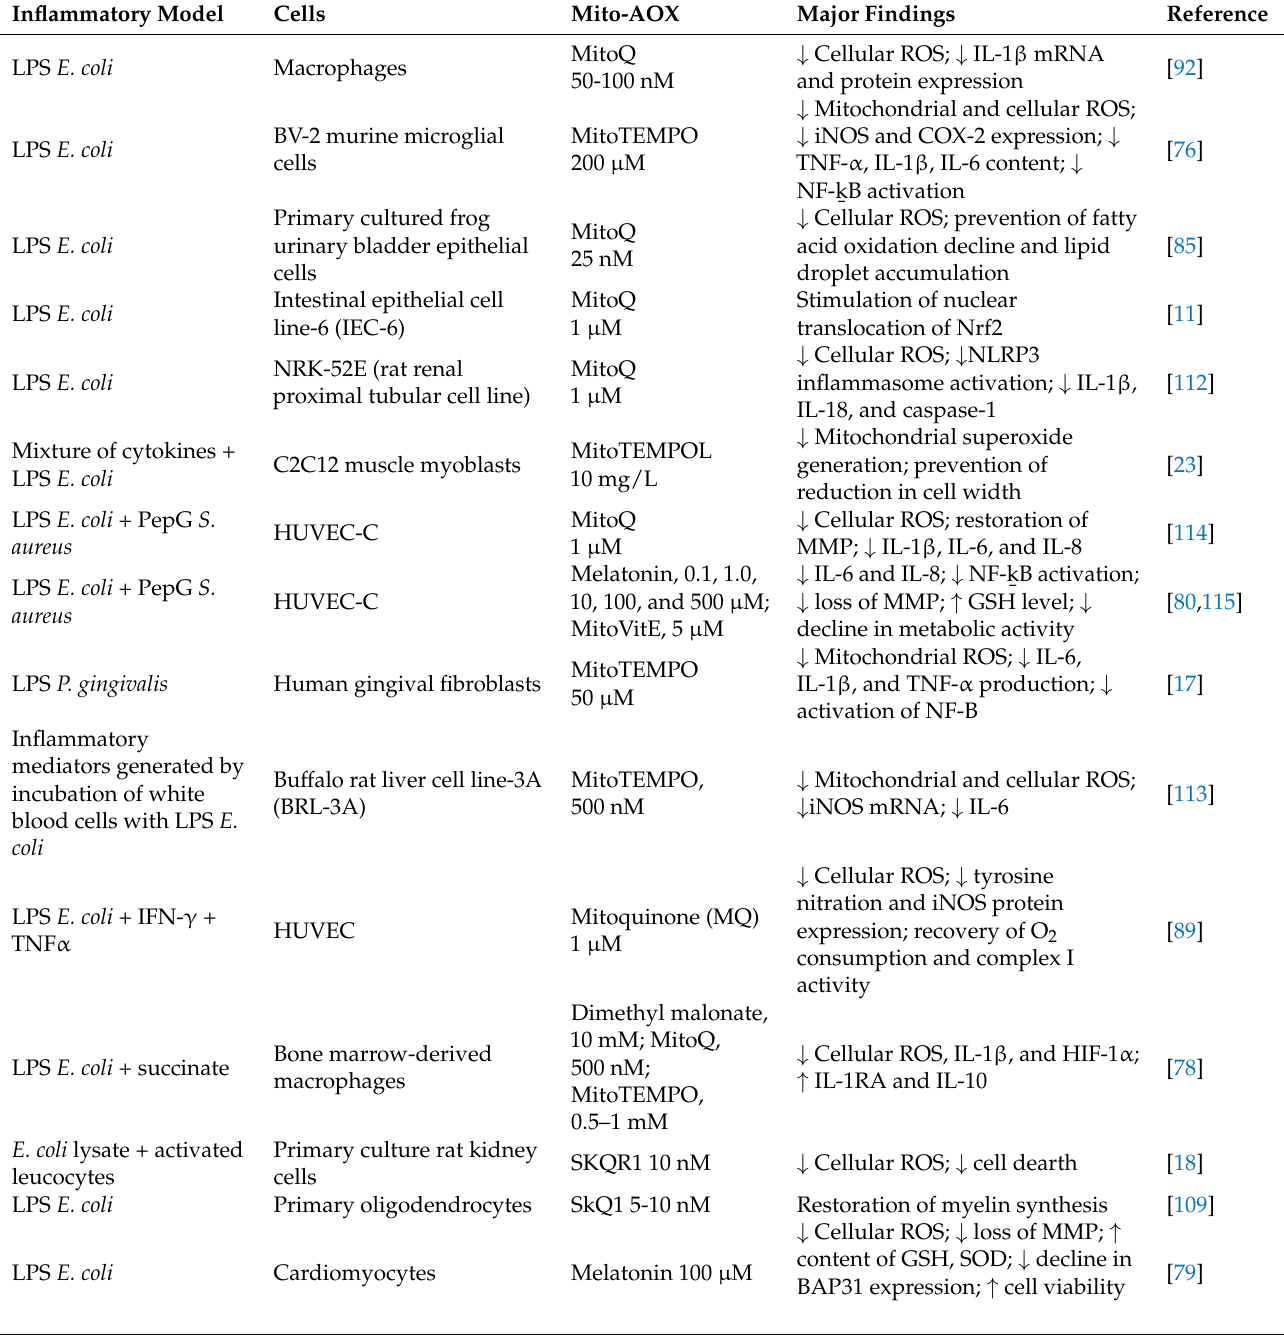
Table 1. In vitro effects of mitochondria-targeted